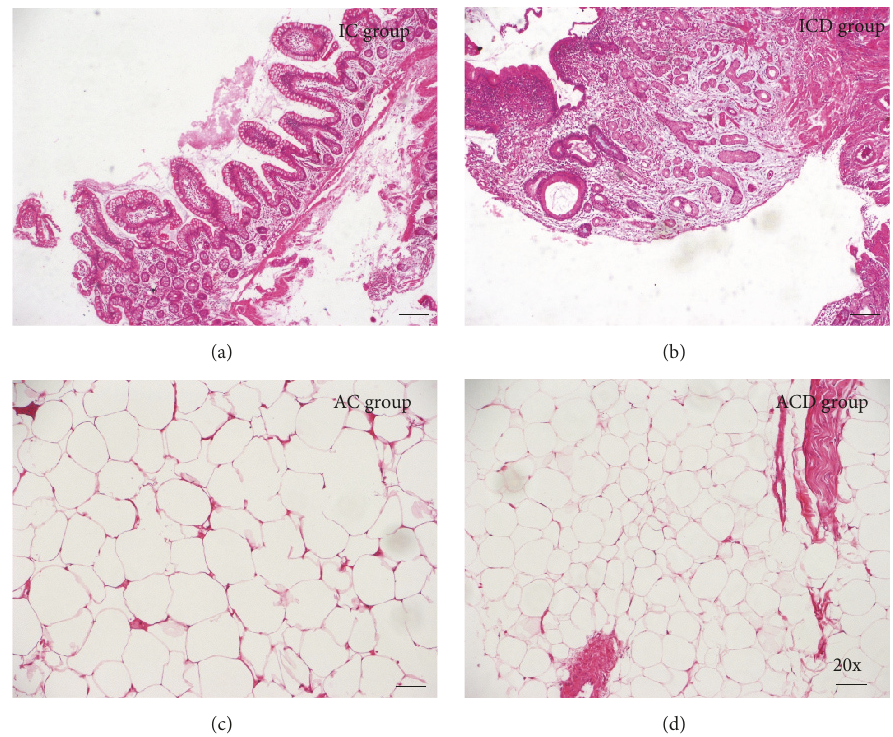
Figure 1: Haematoxylin and Eosin (H&E) staining of intestinal mucosa and mesenteric adipose tissues segments of a representative Crohn’s disease patient. (a) Intestinal mucosa of a normal control subject (IC Group). (b) Intestinal mucosa of CD patient (ICD Group), showing crypt distortion, ulcers, and inflammatory infiltrate. (c) Mesenteric adipose tissue of a normal control subject (AC Group). (d) Mesenteric adipose tissue of CD patient (ACD Group) revealing characteristic morphometric features, with reduced adipocyte size. Nuclear counterstaining: Mayer’s haematoxylin. Original magnification ×